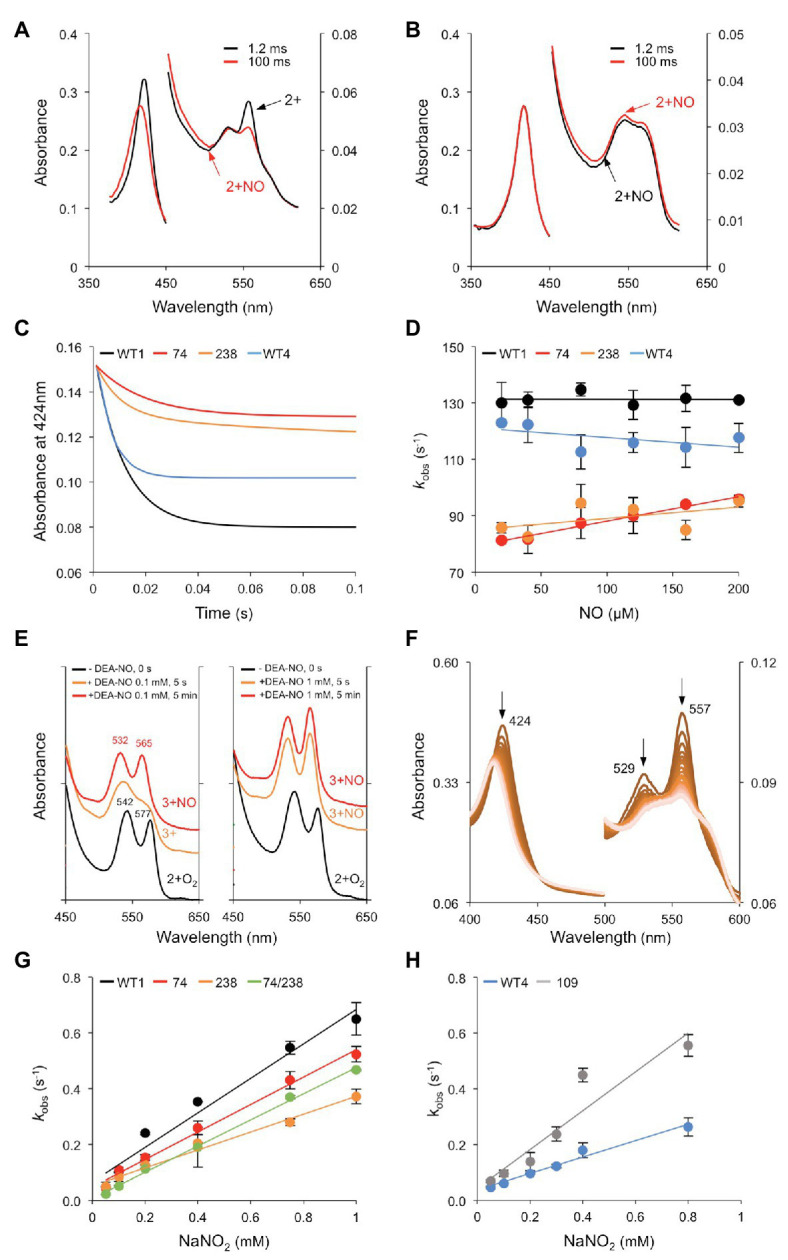
Reactivity of Glbs with NO and NO2−. (A,B) UV-Vis spectra of the reaction of 20 μM NO with 2.5 μM of the deoxyferrous forms of (A) WT1 and (B) 74/238 mutant. Spectra were taken at 1.2 and 100 ms after mixing. Note that, in the double mutant, the nitrosyl complex (2+NO) is already visible in the initial spectrum. (C) Time course of NO binding (20 μM) to the deoxyferrous proteins. Note that the amplitudes for the single mutants are lower than that of WT1 as only one of the hemes is observed with the other having already formed the nitrosyl complex (<1.2 ms). (D) Rate constants of NO binding were calculated from fitting the time course to a single exponential function. The panel shows the plots of observed pseudo first order rate constants (kobs) at pH 7.0 and 25°C vs. NO concentration. The second order bimolecular rate constant was obtained from the linear fit of the data. (E) NOD activity examined by UV-Vis spectroscopy. The oxyferrous form of WT1 (2+O2) was reacted with NO supplied as 0.1 or 1 mM diethylamine NONOate (DEA-NO), and the UV-Vis spectra were taken at the indicated times. The Soret bands and the peak wavelengths of the right plot (identical to those of the left plot) are omitted for clarity. Note the Q bands characteristic of the 3+NO complex. The WT4 protein showed identical behavior. (F) NiR activity of deoxyferrous WT1. The reaction was carried out with 50 μM NO2− and 2.5 μM protein, generating 2+NO under anaerobic conditions. Spectra were taken every 1 s for 1 min, although only 46 spectra are shown for clarity. Note the decrease of the characteristic peaks at 424, 529, and 557 nm of the deoxyferrous globin. (G,H) Kinetics of the reactions between NO2− and the ferrous forms of (G) WT1 and the 74, 238, and 74/238 mutants and (H) WT4 and the 109 mutant. The panels show the plots of observed pseudo first order rate constants (kobs) at pH 7.0 and 25°C vs. NO2− concentration. The second order bimolecular rate constant was obtained from the linear fit of the data.